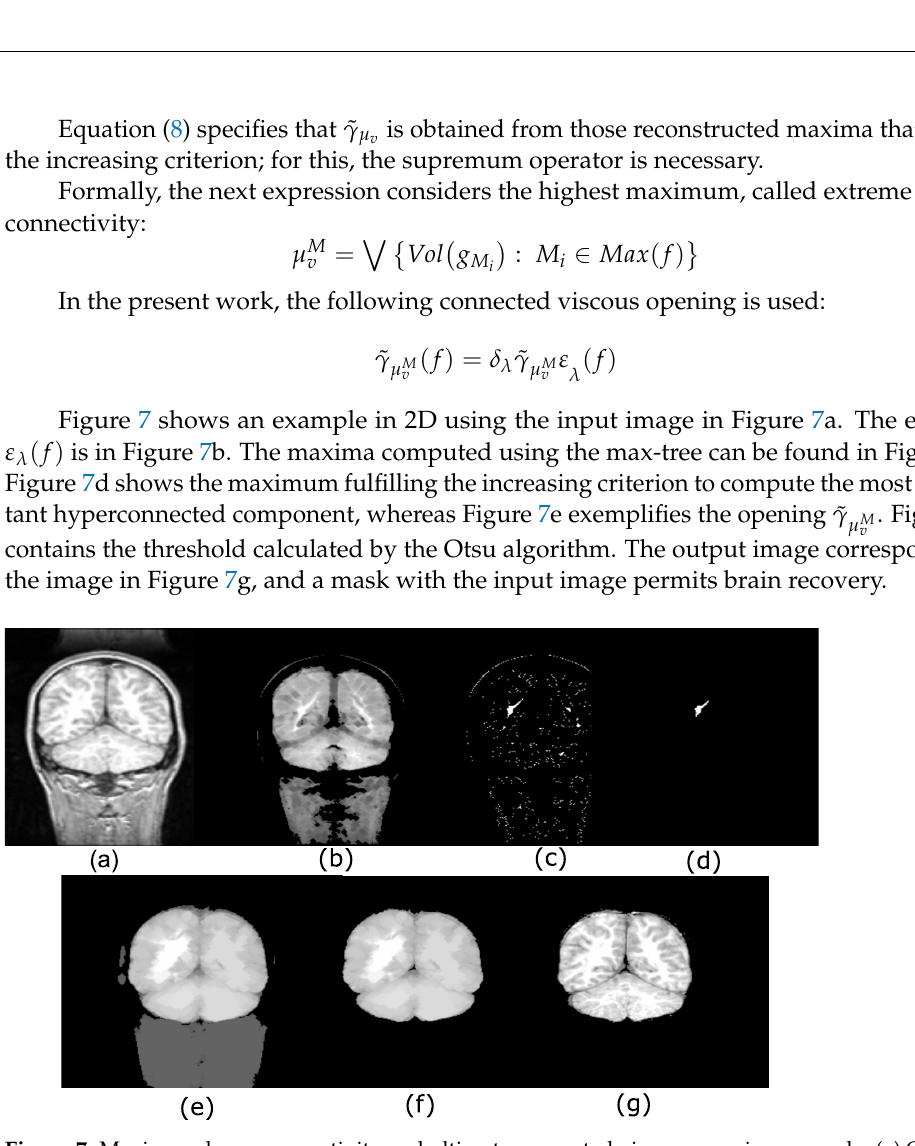
Figure 7. Maximum hyperconnectivity and ultimate connected viscous opening example. ( a ) Original image; ( b ) ε λ ( f ) size λ = 3. The morphological erosion separates brain and skull; ( c ) maxima detection; ( d ) maximum fulfilling the increasing criterion, i.e., the greater volume obtained of a ε λ = 3 ( f ) ; ( f ) Otsu threshold to eliminate low-intensity levels; ( g ) mask max-tree branch; ( e ) δ λ = 3 ˜ γ µ M v with the original